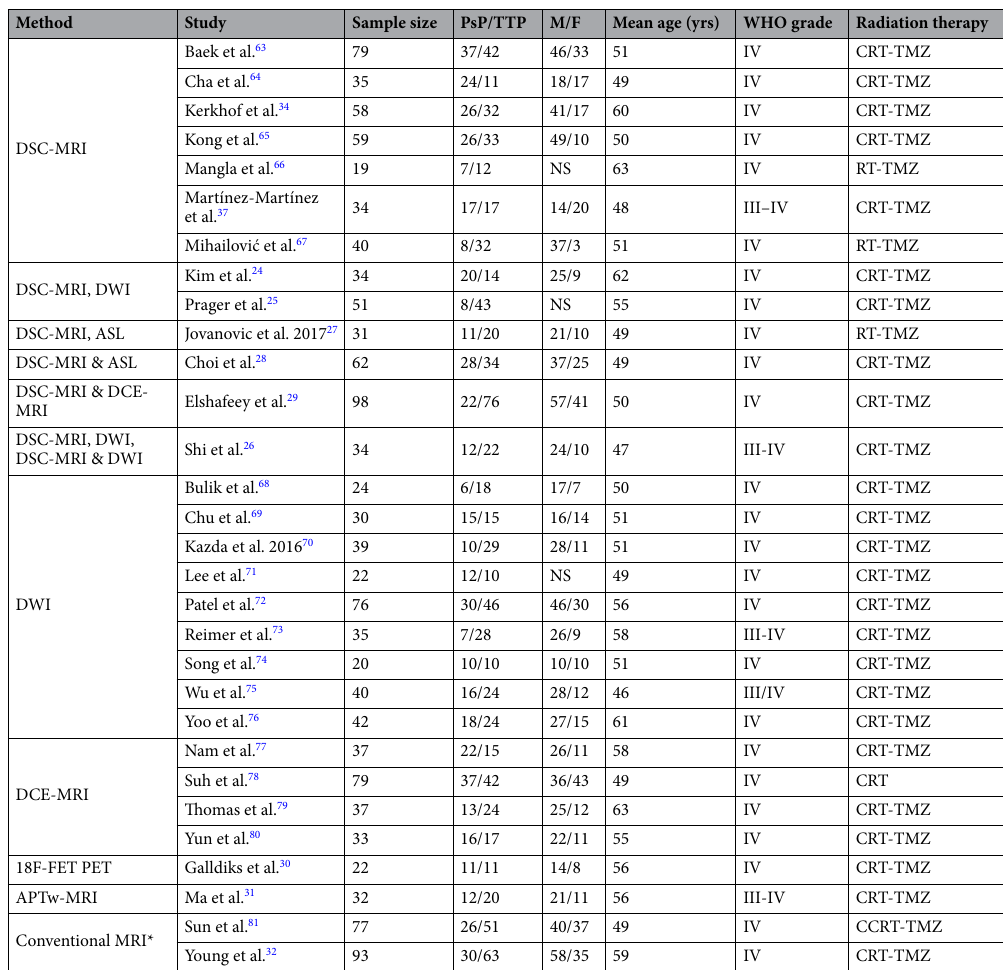
Table 1. Details of included studies. APTw-MRI = amide proton transfer-weighted MRI; ASL = arterial spin labelling; CRT-TMZ = chemoradiotherapy with adjuvant temozolomide; NS = not specified, TTP = true progression. Conventional MRI included contrast-enhanced T1-weighted and T2-weighted